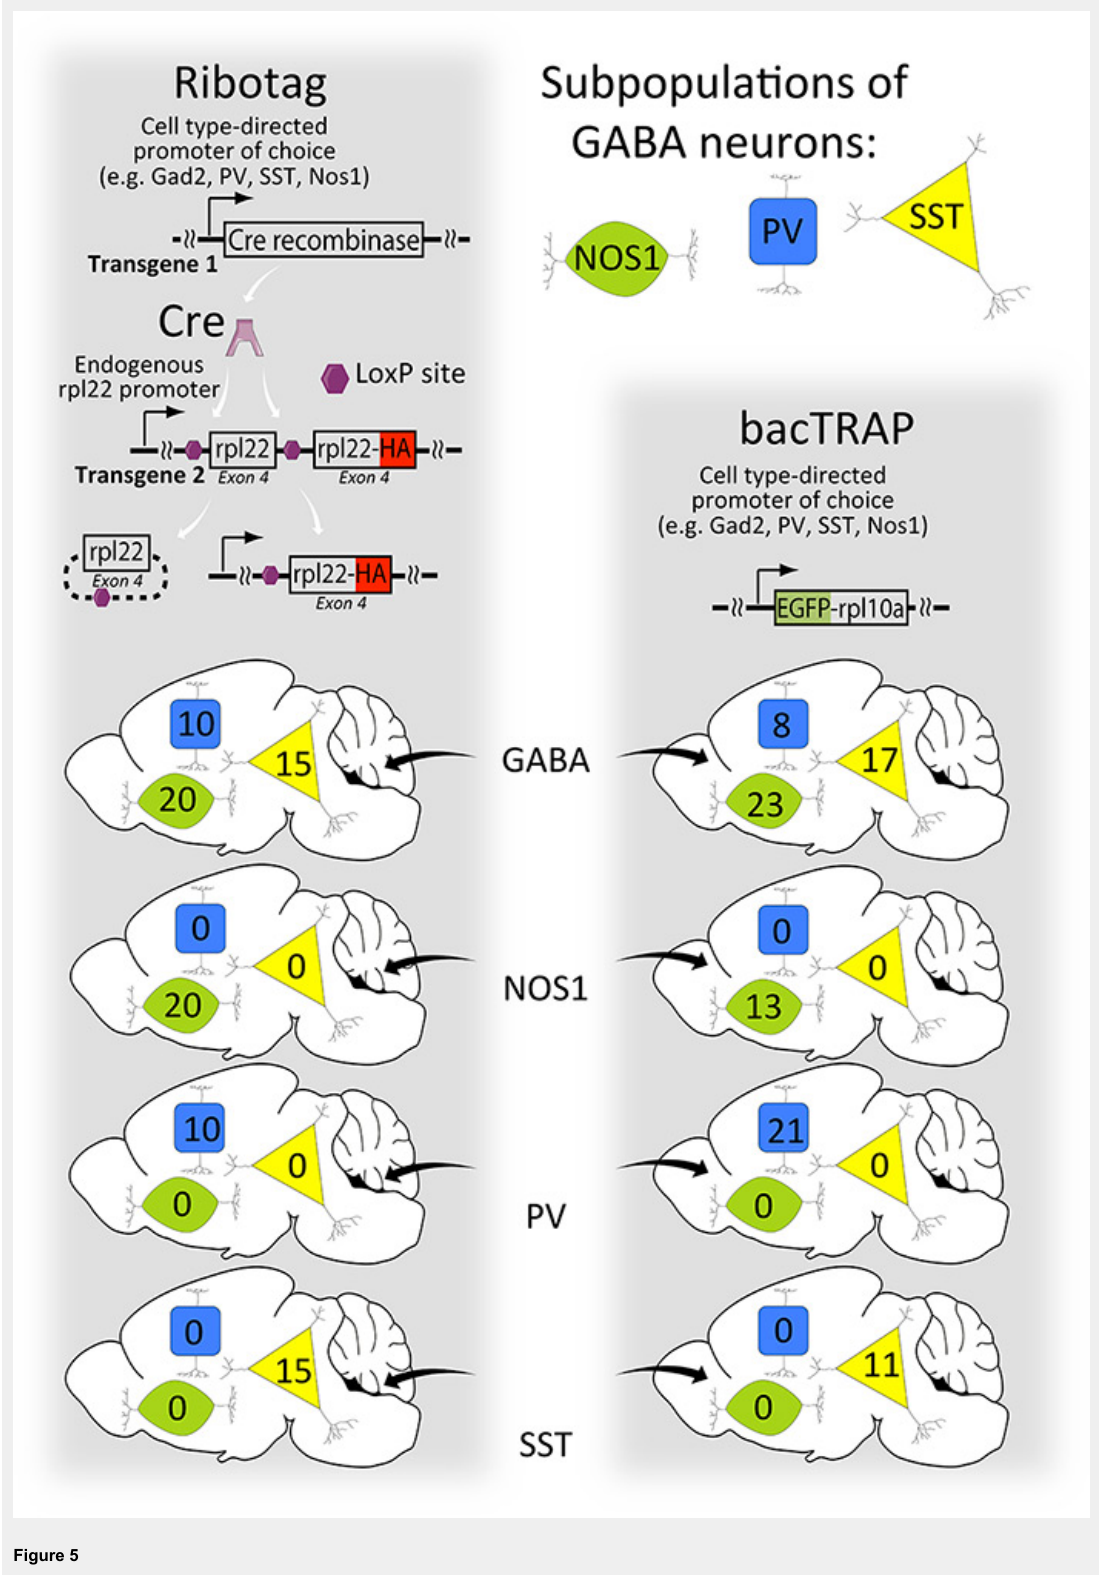
A comparison of Ribotag and bacTRAP methods. In the left pathway, a ubiquitous promoter drives expression of the Ribotag (rpl22-HA) protein only after Cre recombinase activity releases the inhibition of Ribotag expression. The endogenous rpl22 exon 4 functions as a ‘floxed STOP’ for the Ribotag method, as shown in fig. 4. The cell type specificity is determined by the pattern of Cre expression. Therefore, the same cell targeted by different Cre activators will have the same expression level of the Ribotag protein because the same ubiquitous promoter drives its expression from the same place in the genome. In contrast (right pathway), different promoters drive the expression of bacTRAP resulting in different expression levels in this hypothetical example. An important advantage of bacTRAP is that one mouse line is needed versus two for